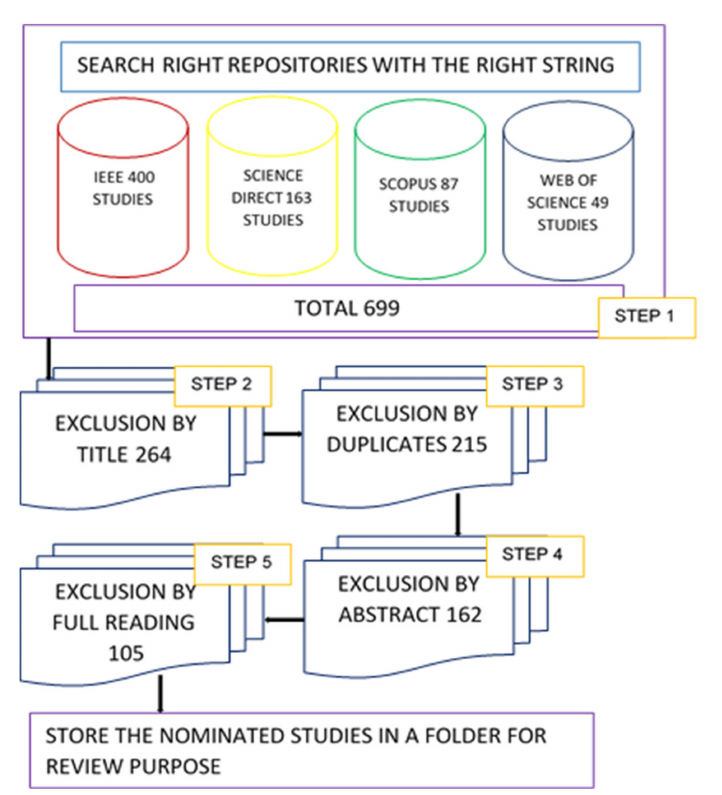
Figure 1. Search and selection